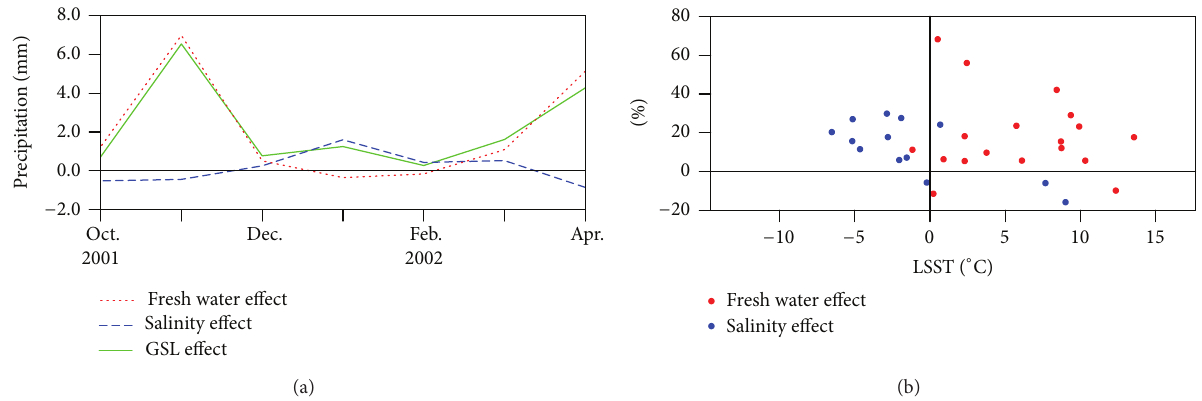
Figure 6: Averaged over (in) the red square in Figure 5(a) and the simulated monthly precipitation ((a) caused by GSL effect, fresh water effect, and salinity effect, resp.) and the percentage of changed simulated daily precipitation (caused by fresh water effect and salinity effect, resp.) with the daily LSST in FL (b).